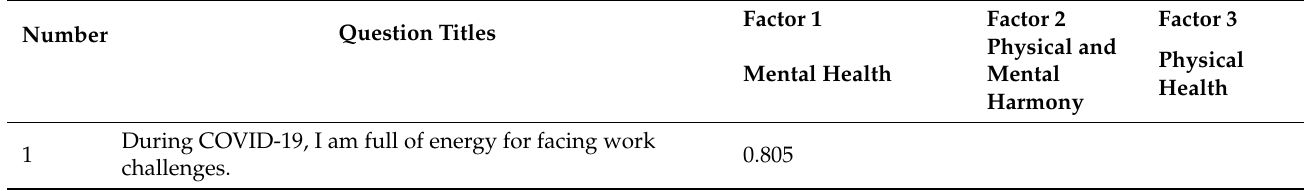
Table 3. Summary table of factor analysis for wellness